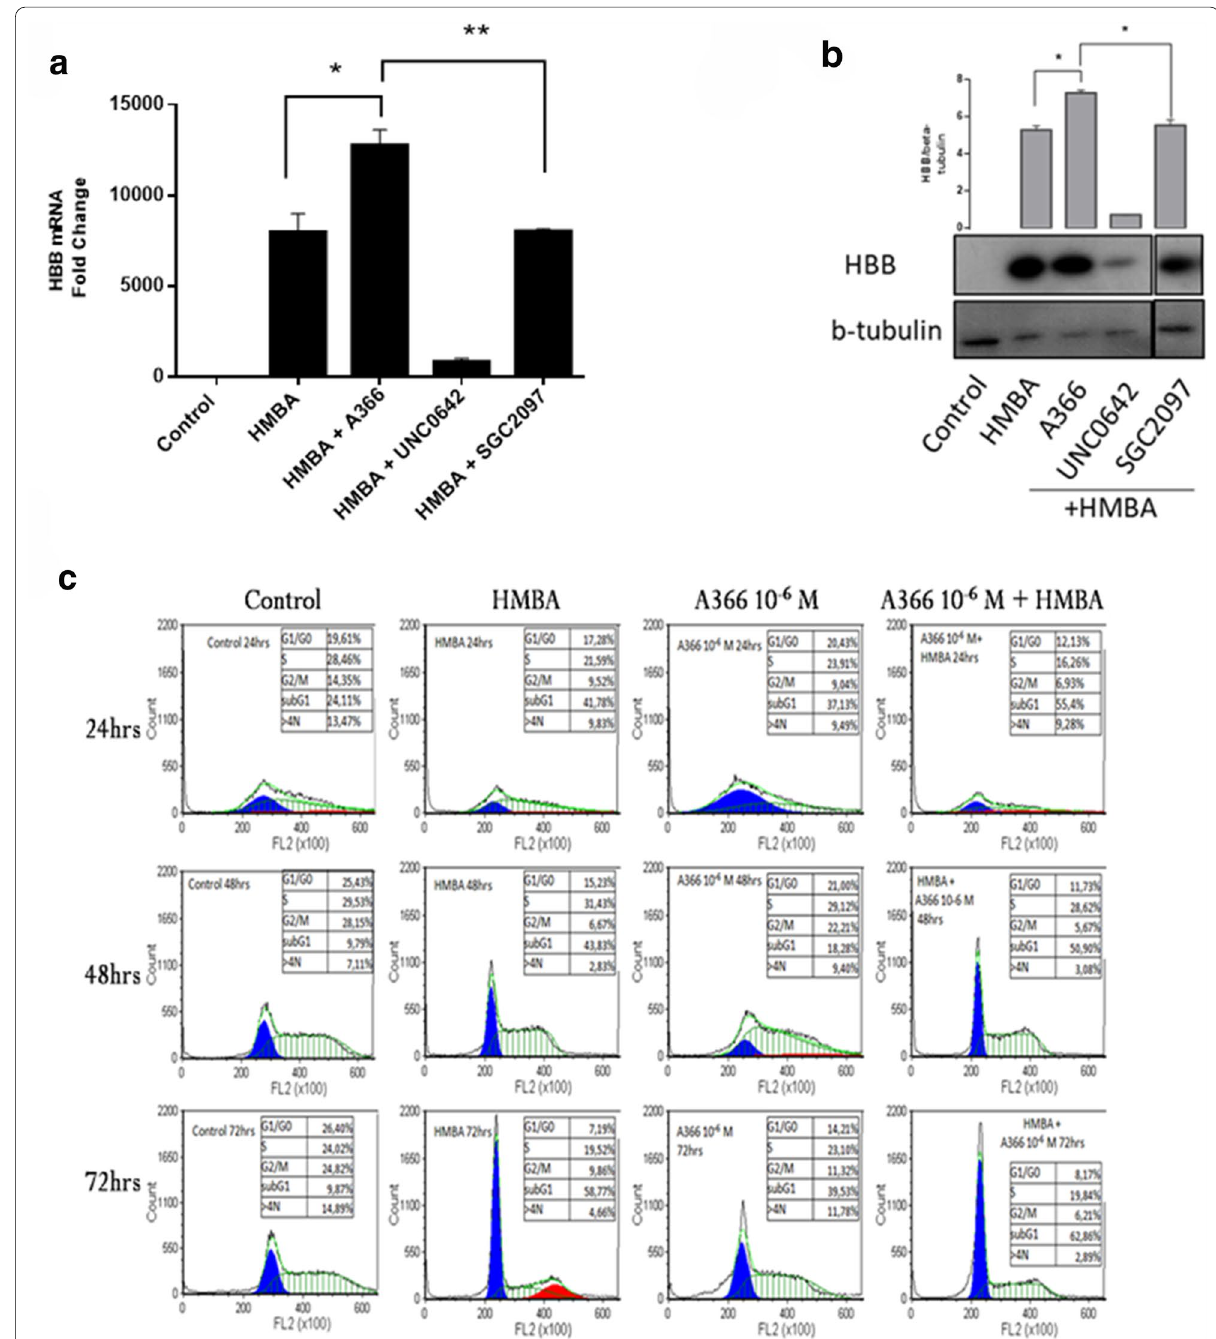
Fig. 4 A-366 alters the cell cycle state of growing and differentiating MEL erythroid cells. Agent concentration for all panels, unless indicated differently: HMBA (5 10 − 3 M), A-366 and SGC2097 (10 − 6 M), UNC0642 (1.6 10 − 6 M). a MEL cells were treated for 48 h with drug combinations × × indicated in the graph. Total RNA isolation was performed, and RNA was processed with cDNA synthesis and qPCR analysis of the β-globin transcripts. Data was normalized to β-actin expression and analyzed according to the 2 − ΔΔCt method. ** p < 0.001; * p < 0.01; Student’s t-test. b MEL cells were treated for 48 h with the indicated drug combinations in the graph, before total protein isolation was performed. Western blot with specific antibodies against β-globin and β-tubulin is shown. * p < 0.05; Student’s t ‐ test. c Flow cytometry analysis of the indicated in the graph drug combinations for 24 h, 48 h and/or 72 h. Graph shows the distribution of single cells (MEL cells) into the phases of the cell cycle. Data in all panels represent means standard ±